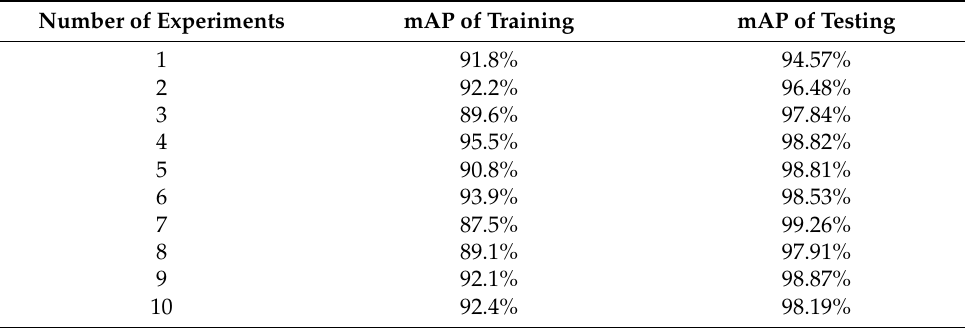
Figure 11. Experimental results of 40,000 epochs. Table 5. Results of 10